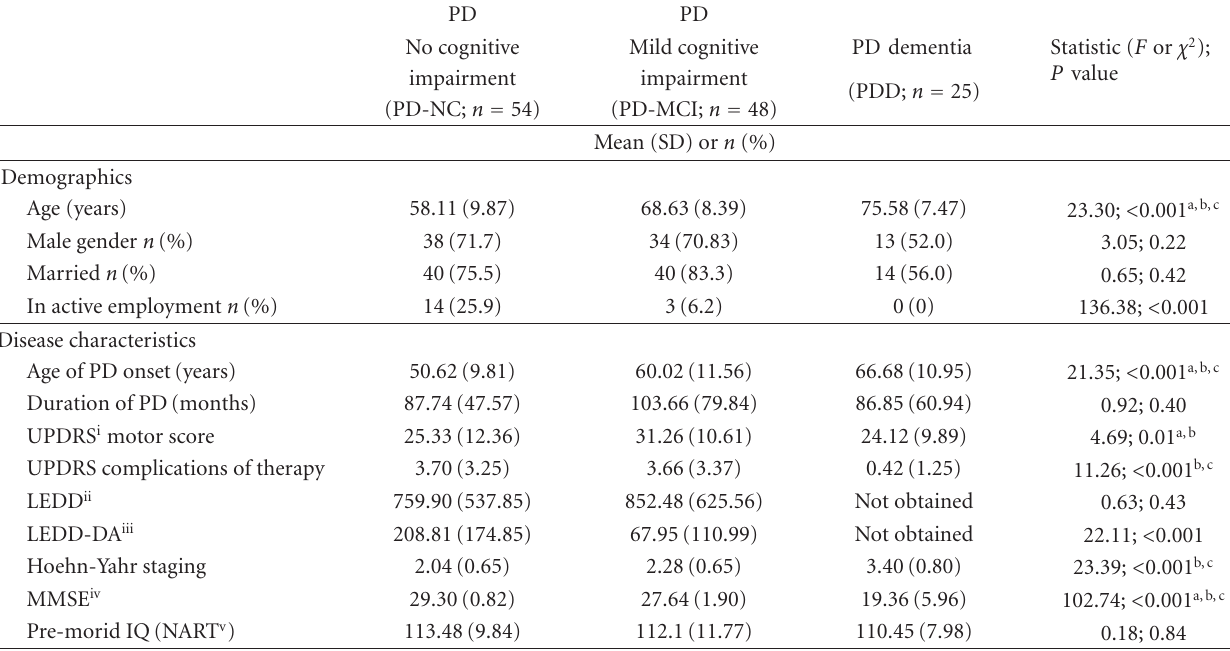
Table 2: Demographics and clinical characteristics of PD participants by group: without cognitive impairment, mild cognitive impairment, and